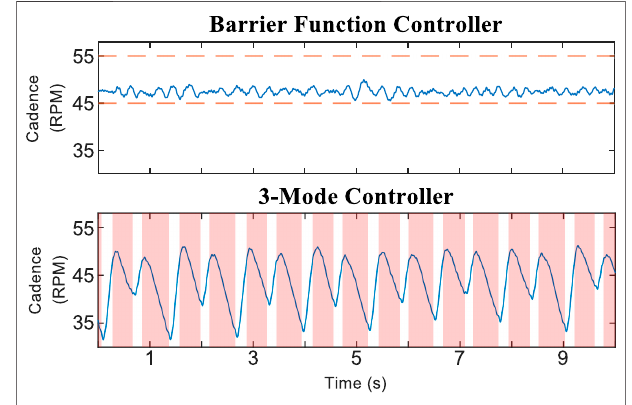
FIGURE 2 | Cadence and motor control input for 30-s segments of the trials using Protocol A. Random selection was used to choose which participants and time periods were plotted. The time axis is offset to zero for readability. The dashed orange line in the barrier function cadence plot indicates the boundary of the safe set S , which was not meaningful for the other two con fi